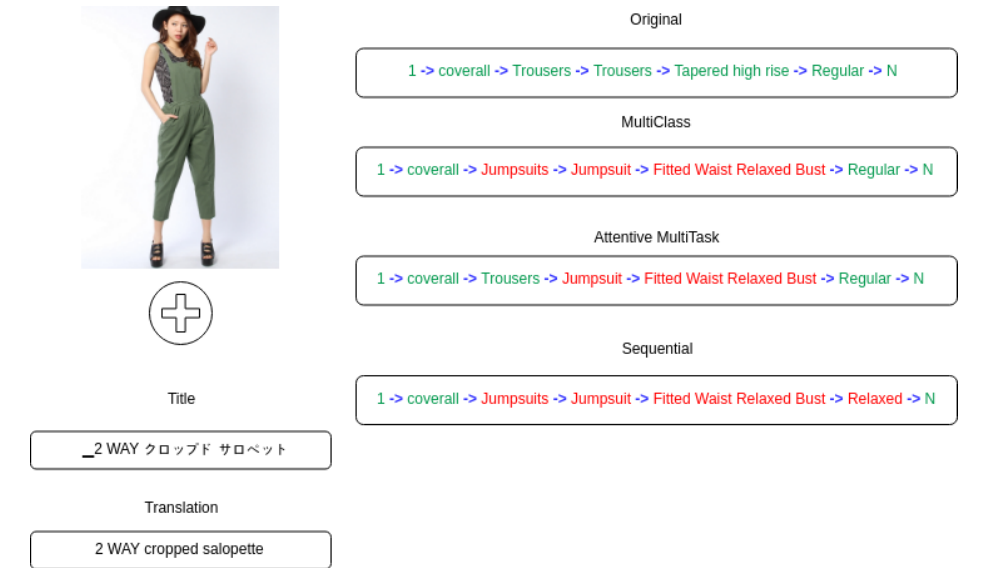
Figure 5. A sample item from the Rakuten test set with predicted attribute chains. Correctly predicted attributes are in green, the wrongly predicted attributes are in red.